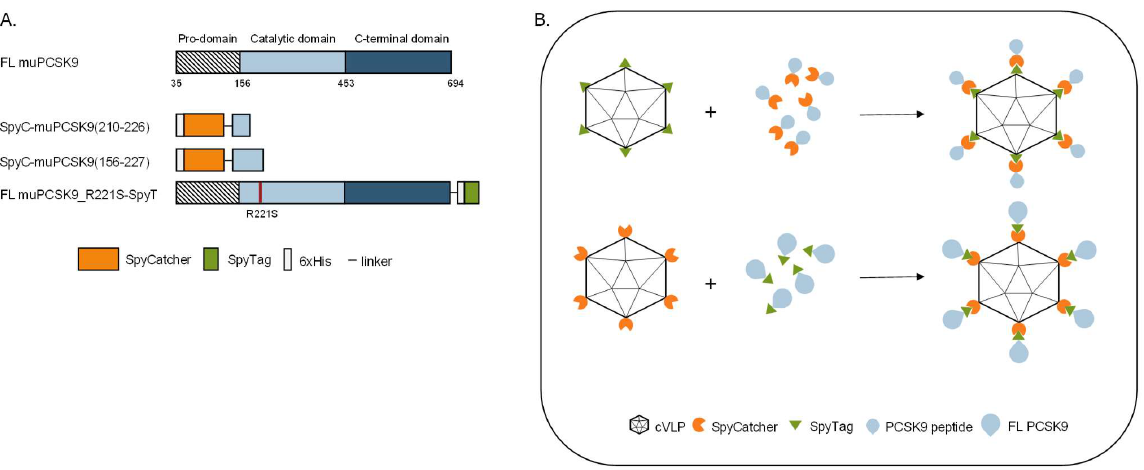
Figure 1. PCSK9 vaccine design. ( A ) Schematic representation of FL murine PCSK9 and the three PCSK9 antigen designs. FL muPCSK9 consists of a pro-domain, a catalytic domain and a C-terminal domain. Two peptide-based muPCSK9 antigens consisting of amino acid (aa) 210–226 and 156–227 were each N-terminally fused to a hexahistidine tag and SpyC, referred to as SpyC-PCSK9(210–226) and SpyC-PCSK9(156–227), respectively. The third antigen consists of the FL muPCSK9 construct, with the introduction of an R221S mutation to prevent furin cleavage, a C-terminal hexahistidine tag and SpyT, referred to as FL PCSK9-SpyT ( B ). Schematic representation of the Spy-AP205 technology used to create the cVLP-PCSK9 vaccines. Genetic fusion of either the SpyT (top) or SpyC (bottom) to the AP205 capsid protein (total of 180 subunits per cVLP) allows for unidirectional and high-density coupling of the PCSK9 antigen containing the corresponding binding partner.